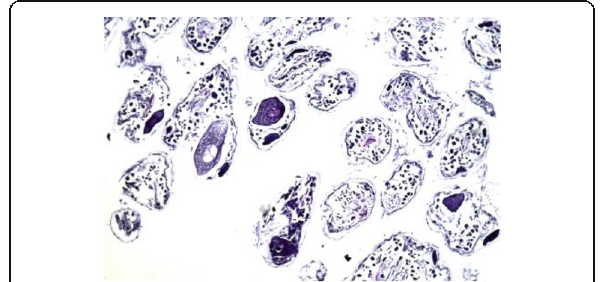
Fig. 5 Ovotestis of Eobania vermiculata treated with emamectin